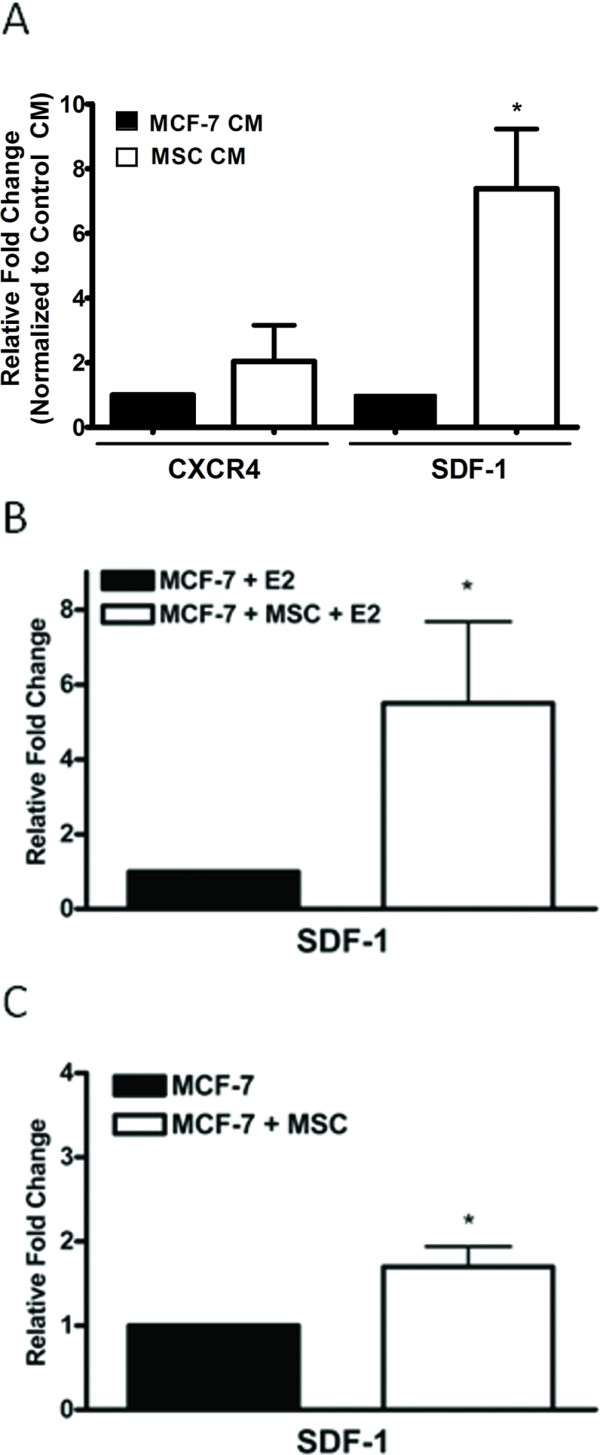
hMSCs enhance SDF-1 gene transcription in vivo and in vitro. (A) MCF-7 cells were treated with conditioned media from MCF-7 cells (control) or hMSCs for 24 hours. Cells were then harvested for PCR analysis of CXCR4 and SDF-1. (B) Endpoint oestrogen and matrigel tumours were harvested at day 36 post cell injection and gene expression analyzed by qPCR. (C) Endpoint matrigel tumours grown in the absence of oestrogen were harvested at day 44 and gene expression analyzed by qPCR. Data represent fold change relative to control as normalized to internal β-actin ± SEM, (*, p < 0.05).